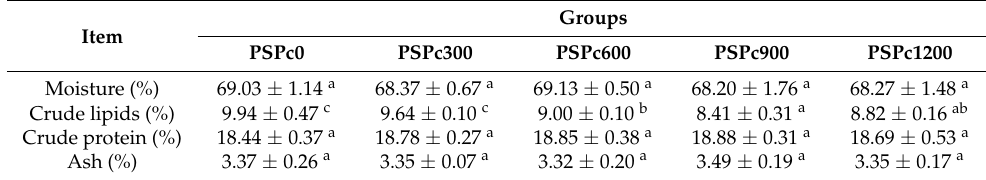
Table 2. Proximate composition in whole fish of juvenile American eel in different PSPc